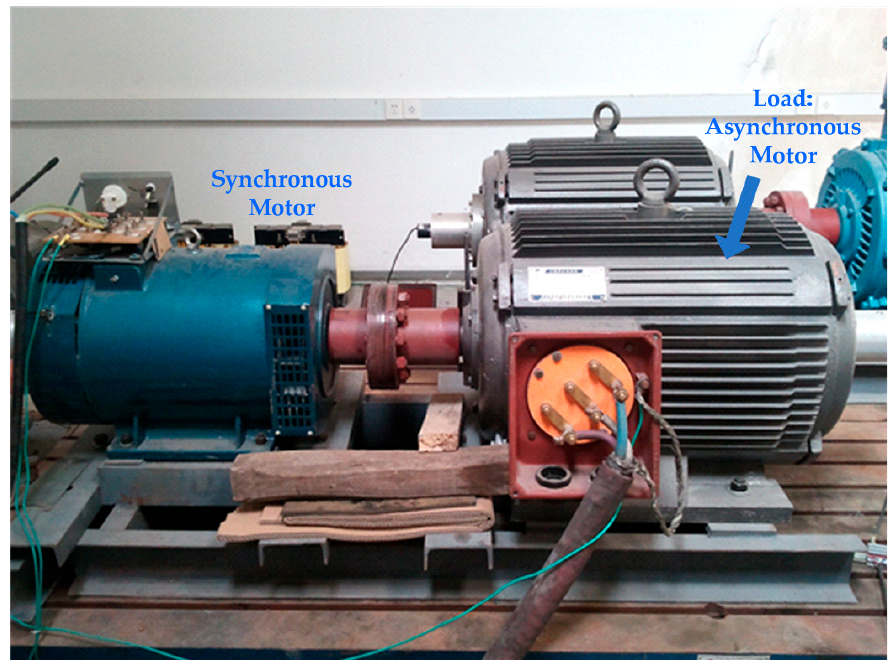
Figure 13. Dynamic trace diagram of stator current.